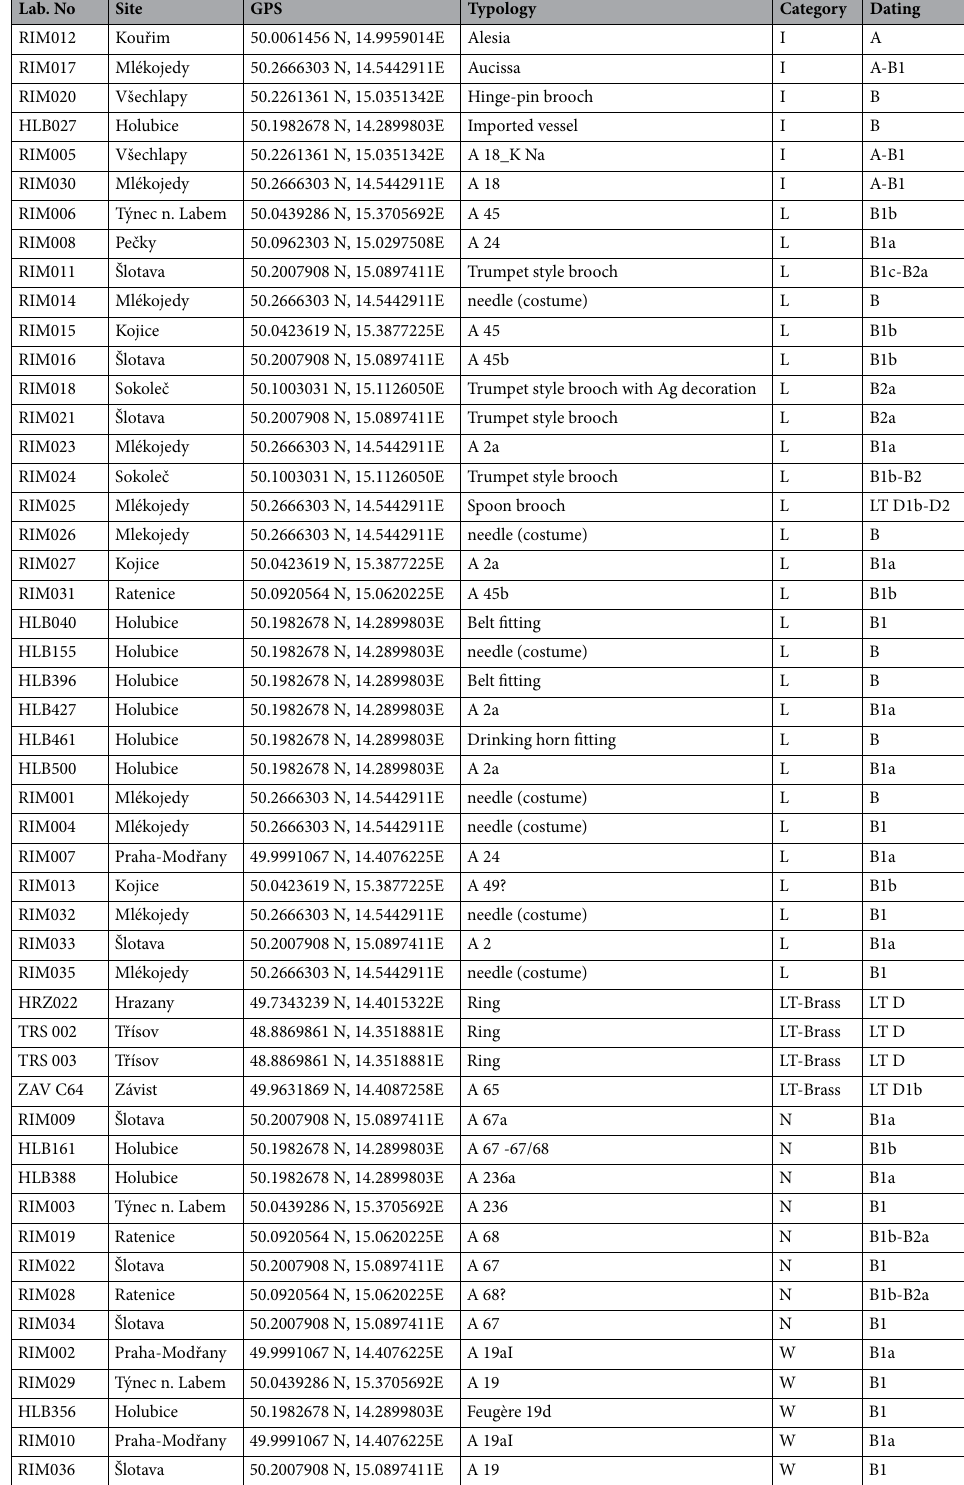
Table 2. Description of analysed samples with their localisation, category of cultural provenance (see chapter 2.2 and Table 1), and dating. Brooches in the typological system of O. Almgren 94 were abbreviated as A ( X